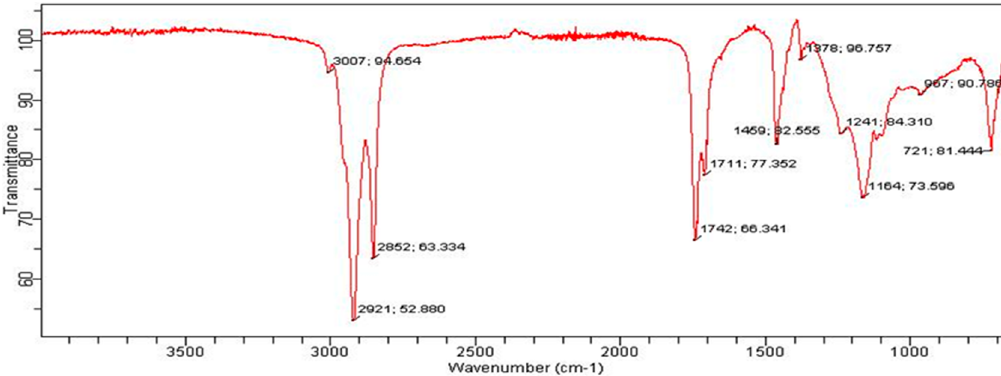
Figure 2. FTIR spectrum of PBC.